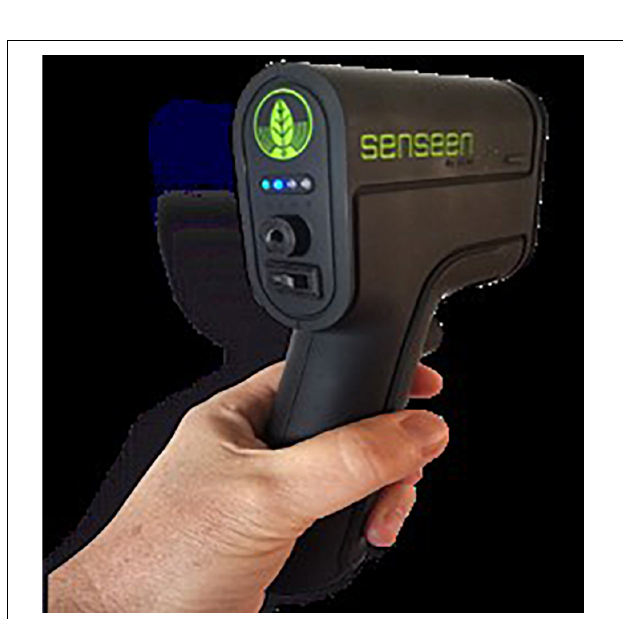
FIGURE 4 | Low-cost NIR spectrometer prototype for measuring